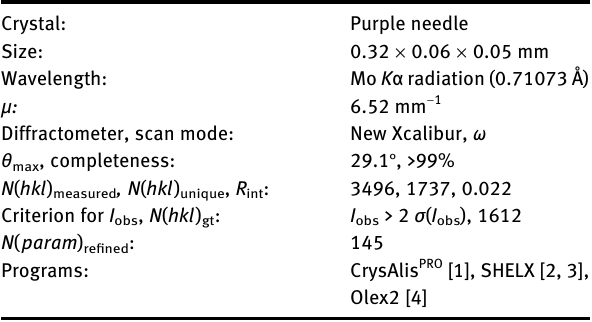
Table  : Data collection and